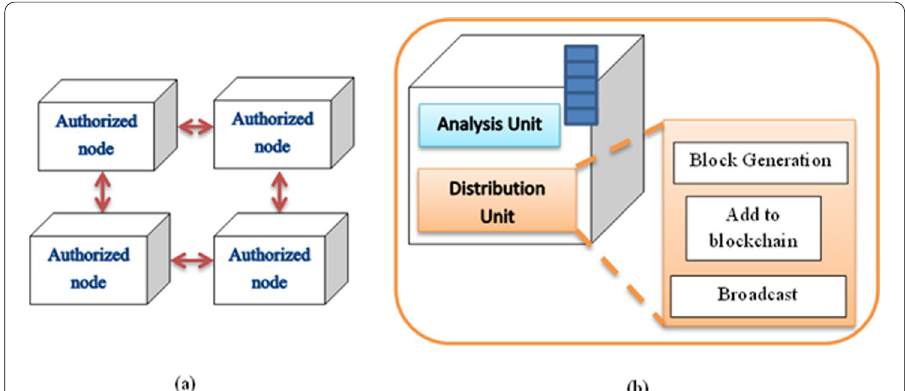
Fig. 5 Blockchain framework: a blockchain network of BC-HyIDS and b individual node structure. BC-HyIDS system is a private blockchain network implemented using Hyperledger platform. As it is a private and permissioned network it consists of only authorized nodes. All nodes are connected to each other in a chain. Each node is able to do all functionality using analysis and distribution